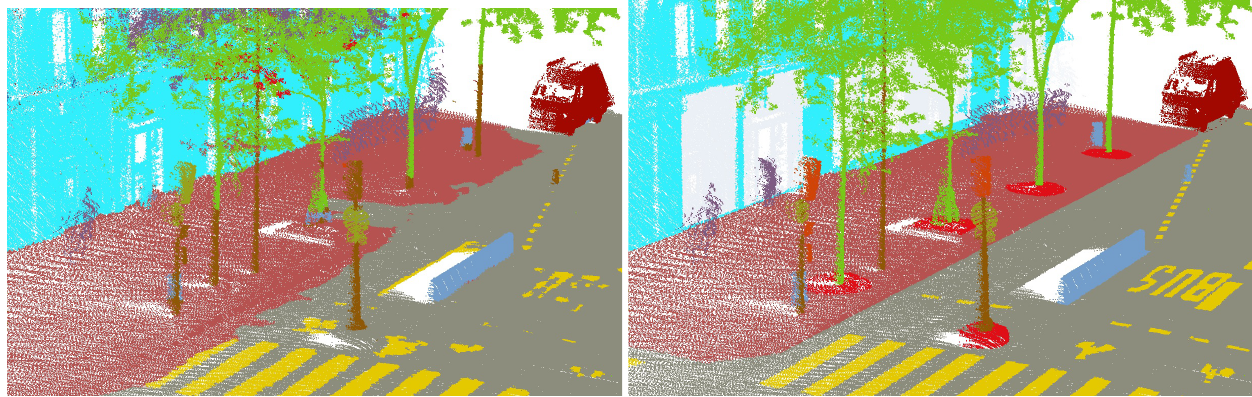
Figure 3. Left , prediction in S 0 test set of Paris data using KPConv model. Right , ground truth.